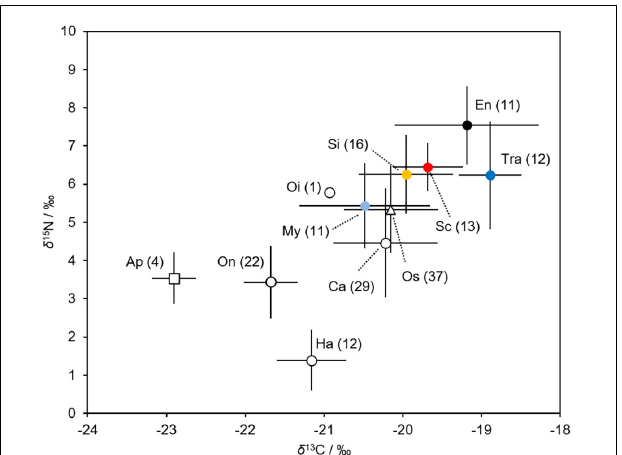
FIGURE 7 | Mean values of carbon ( δ 13 C/